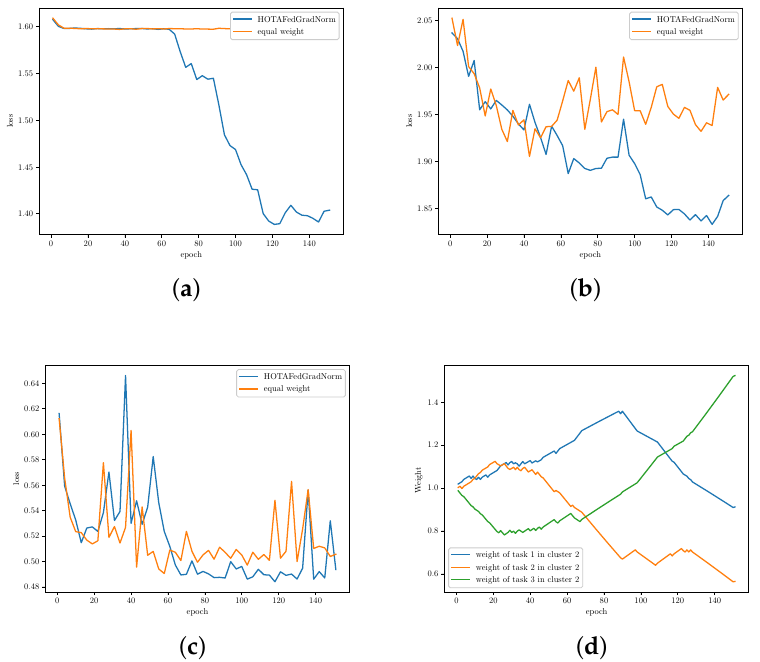
Figure 6. Comparison between task loss achieved via HOTA-FedGradNorm and naive equal weight- ing case in RadComDynamic dataset for the second cluster where σ 2 ( a ) task 1 (modulation classification), ( b ) task 2 (signal classification), ( c ) task 3 (anomaly behavior), ( d ) task